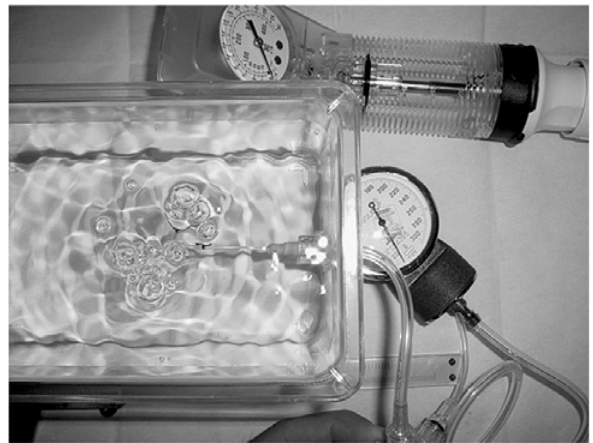
Fig. 5 - Amostra arterial mostrando o momento da ruptura e o vazamento